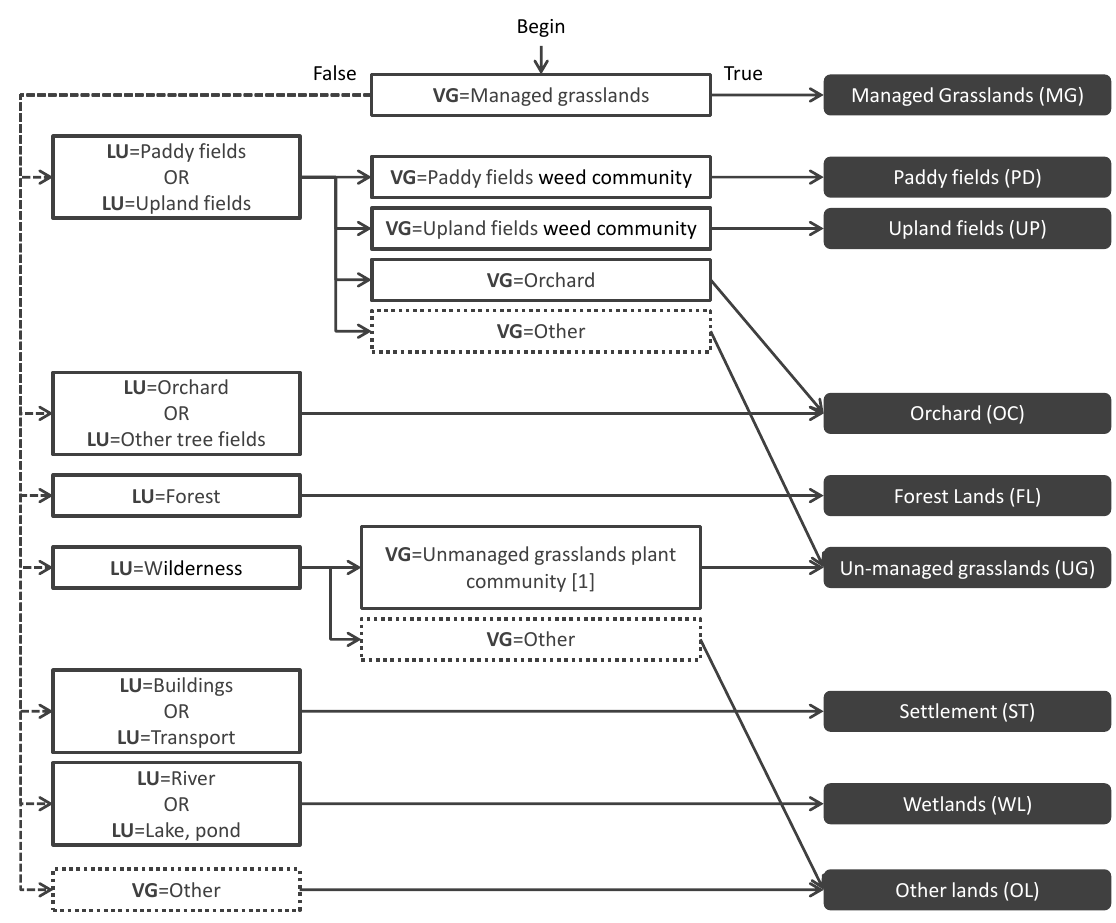
Figure 2. Diagram of interpretation of land-use or land-cover type using multiple different sources of land-use or land-cover map: LU – Land Use Fragmented Mesh Version 1.1 in National Land Numerical Information, created by Ministry of Land, Infrastructure, Transport and Tourism, the Government of Japan; VG – vegetation map from Vegetation Naturalness Survey conducted in National Survey on the Natural Environment, created by Ministry of Environment (MOE), the Government of Japan. Note that for land-use/land-cover interpretation for 2006, VG was substituted by another geographical data source, AL, agricultural land map from Basic Survey on Improvement of Agricultural Production Base, produced by Ministry of Agriculture, Forestry, and Fisheries (MAFF), the Government of Japan, due to a lack of data in VG data set in this period. For details on each geographical data sources, see the